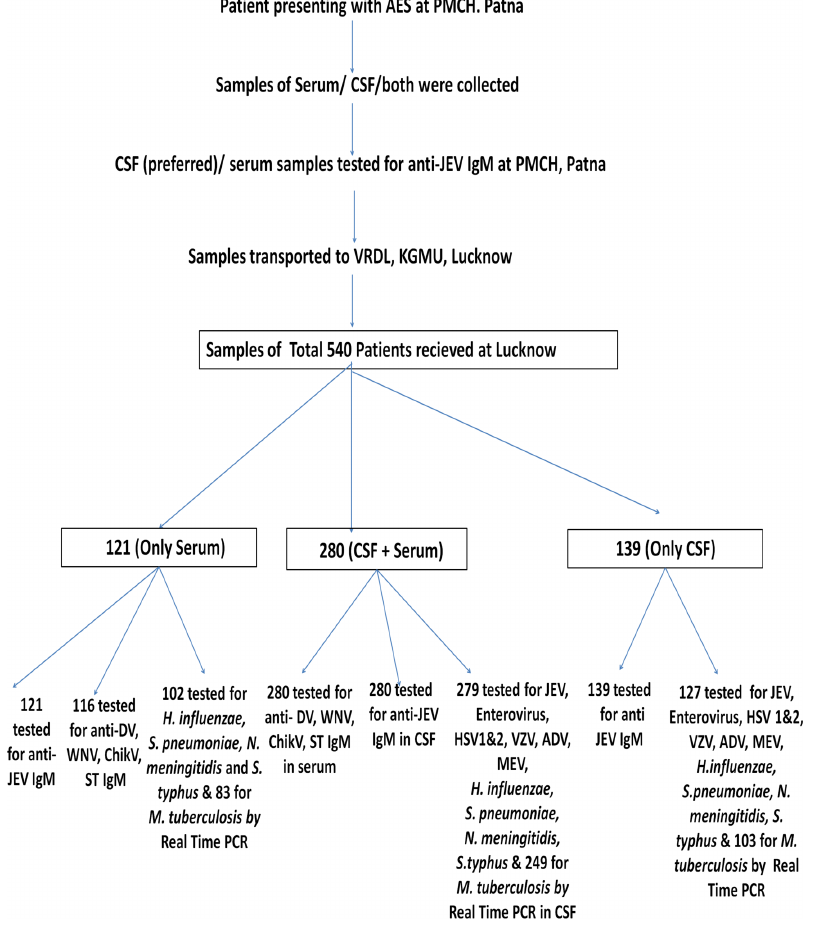
Fig 1. Patient enrolment, samples collected and tests done in patients enrolled in the